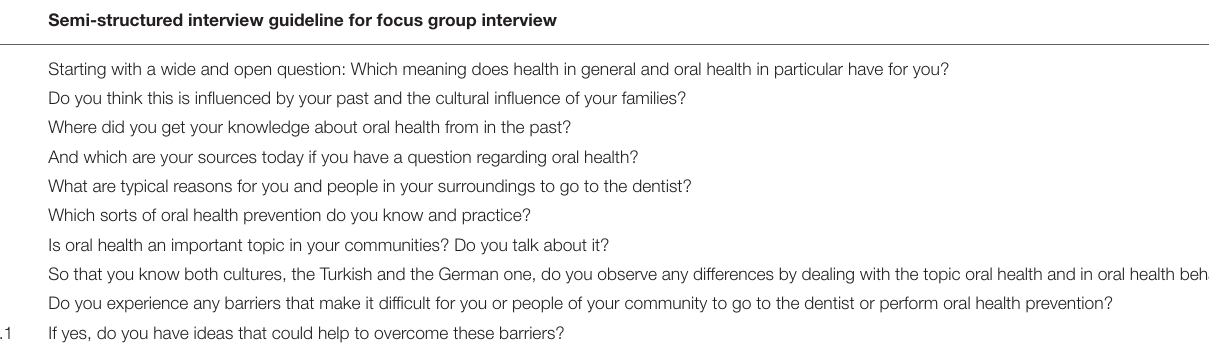
TABLE 2 | Semi-structured interview guideline for focus group interview. Semi-structured interview guideline for focus group